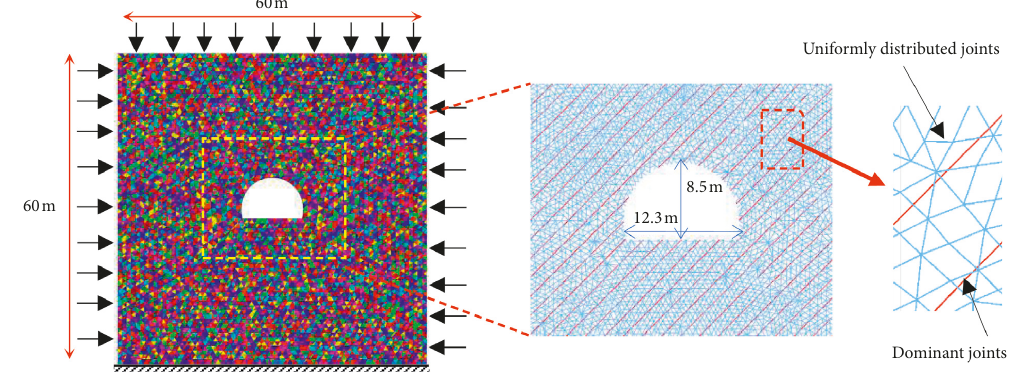
Figure 13: Numerical computation calculating to 2000 steps, the maximum displacement of the the red monitoring line indicates the same position on the monitoring point on the left side was 0.28 m and that on the right side. When calculating to 1000 steps, the asymmetry of right side was 0.22 m under the support of the steel arch, surrounding rock deformation was not obvious under two which resulted in the phenomenon of asymmetric supporting measures (Figures 15(a) and 16(a)). When